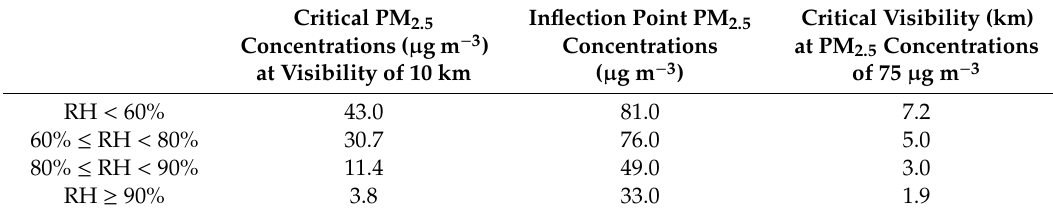
Table 3. The critical PM 2.5 concentrations on the fitting curves at visibility of 10 km, and the inflection point PM 2.5 concentrations and the critical visibility values on the fitting curves at PM 2.5 concentrations of 75 µ g m − 3 in di ff erent RH